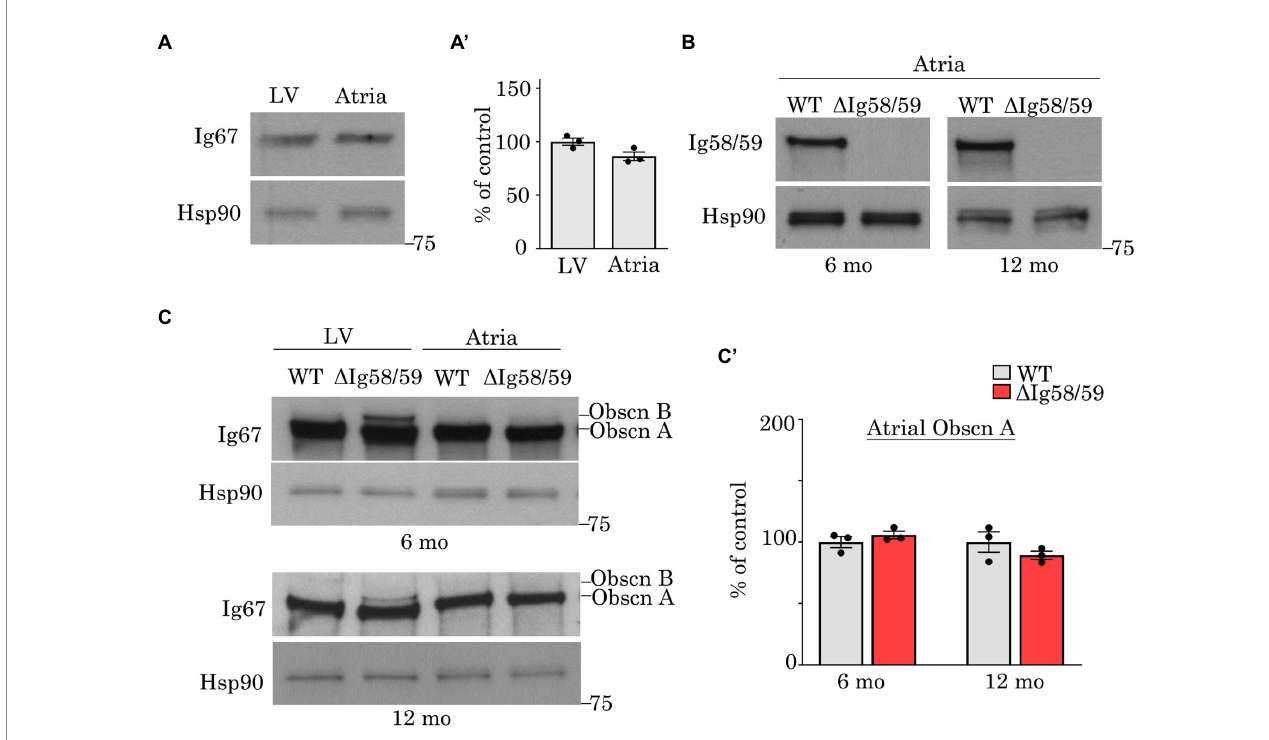
FIGURE 1 Expression levels of obscurin in wild-type and Obscn- Δ Ig58/59 atria. (A,A’) Immunoblotting (A) and relative quantification (A’) of giant obscurin in wild-type 12-month-old left ventricles (LV) and atrial lysates utilizing antibodies to Ig67 did not reveal significant expression differences; t -test, p = 0.18. (B) Immunoblotting of giant obscurin in 6- and 12-month-old wild-type and Obscn- Δ Ig5859 atria using antibodies to Ig58/59 confirmed the Ig58/59 deletion. (C,C’) Immunoblotting (C) and relative quantification (C’) of giant obscurin in 6- and 12-month-old wild-type and Obscn- Δ Ig5859 LV and atria using antibodies to Ig67 indicated that obscurin A expression is unchanged in Obscn- Δ Ig5859 atria compared to wild-type; t -test, p = 0.32 (6-months), p = 0.36 (12-months). Notably, the up-regulation of obscurin B observed in Obscn- Δ Ig5859 LV was barely detectable in Obscn- Δ Ig5859 atria; n = 3